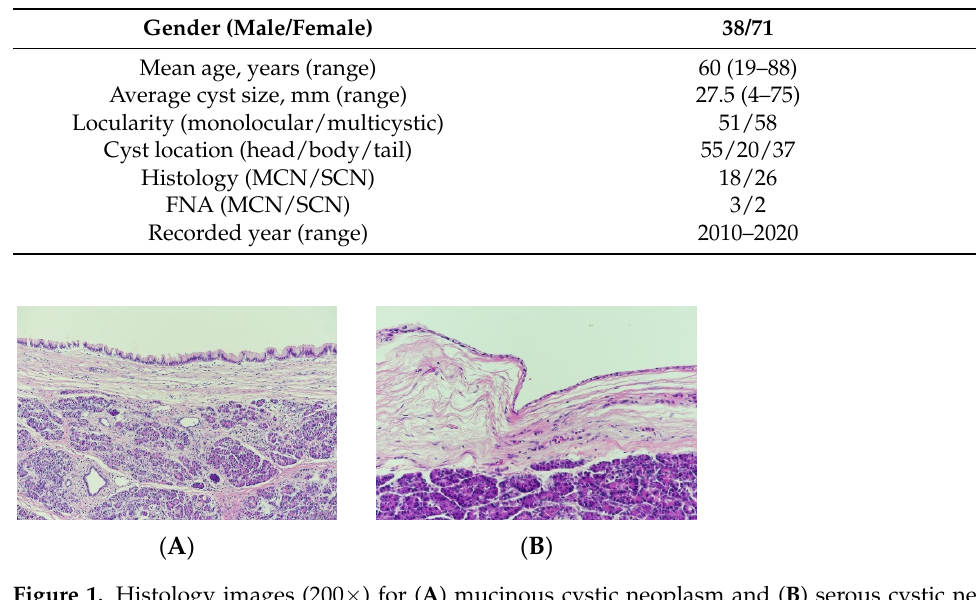
Table 1. Patient and lesion characteristics. (MCN: mucinous cystic neoplasm, SCN: serous cystic neoplasm).